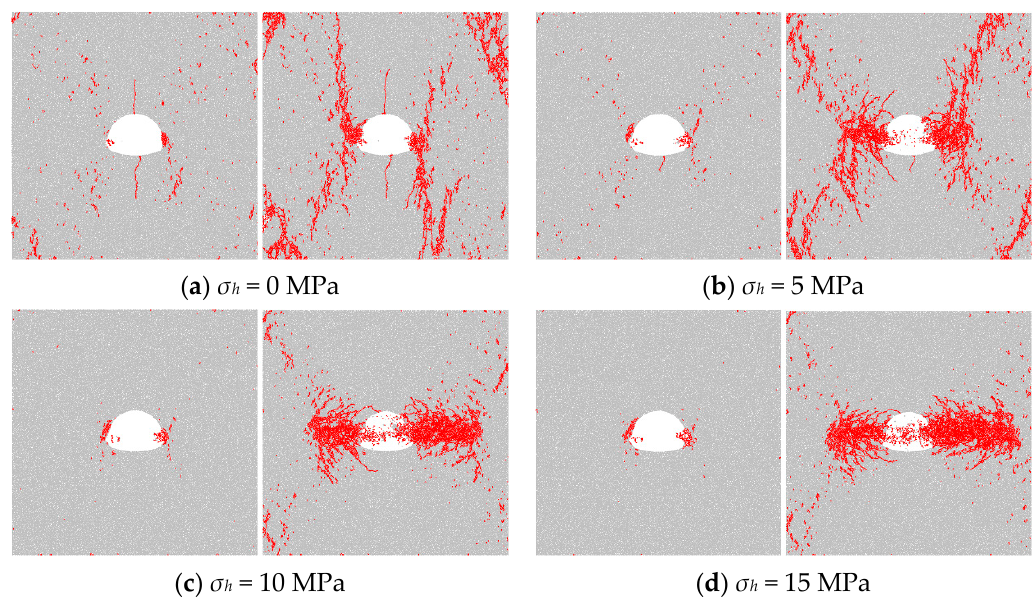
Figure 15. Failure patterns of numerical specimens containing an arched opening.